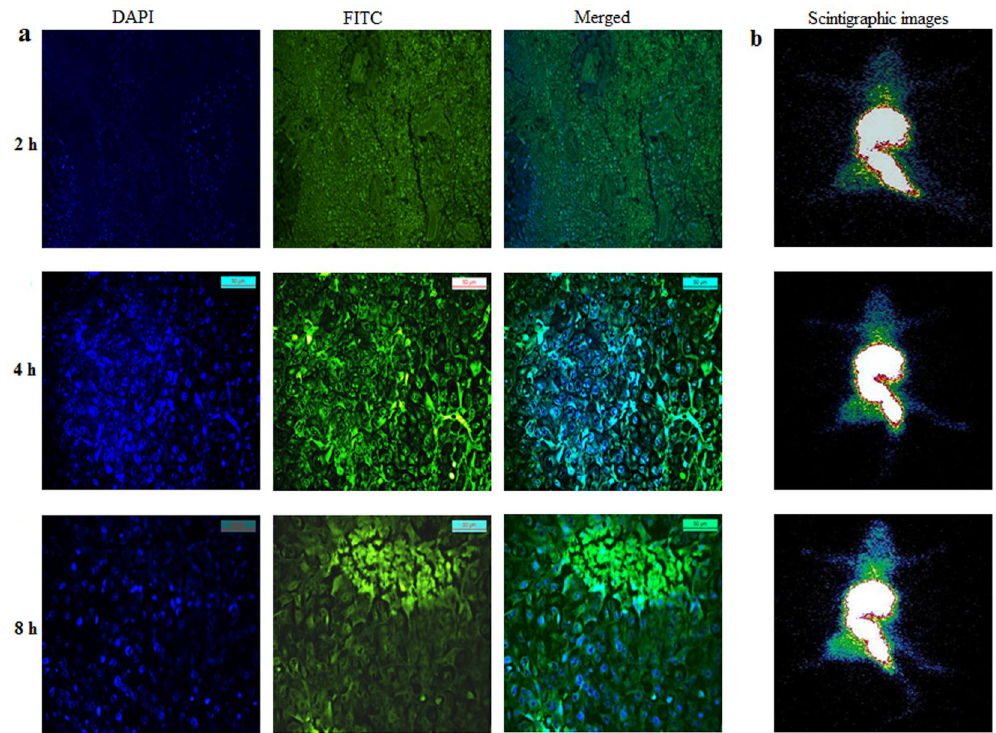
Figure 6. ( a ) Fluorescence images of B16F10 melanoma tumor sections excised at 2 h, 4 h and 8 h after i.v. injection of FITC labeled NP. The green color maps the distribution of FITC labeled NPs and blue color represents DAPI stained nuclei ( b ) scinitgraphic images of 99m Tc labeled GAR-NPs in B16F10 tumor bearing Balb/c mice at 2 h, 4 h and 8 h post injection time